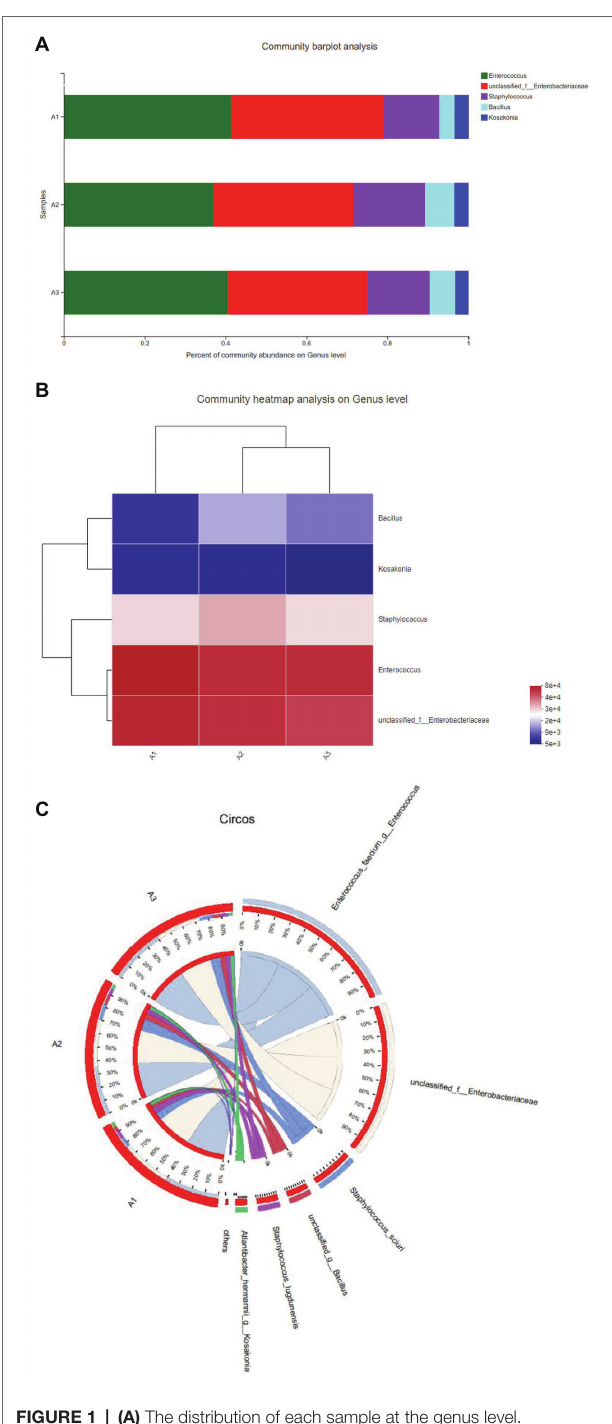
FIGURE 1 | (A) The distribution of each sample at the genus level. (B) Sample and genus relationship. (C) The abundance changes of different bacteria in each sample at the genus level. The right side of the figure shows the value represented by the color